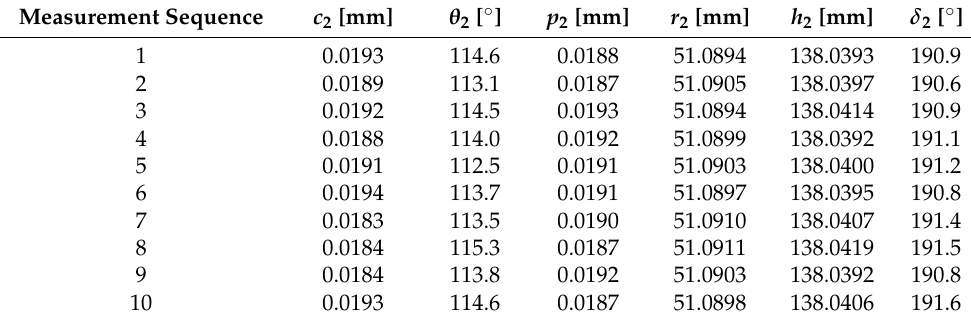
Table A2. The measured geometric parameters of the compressor.